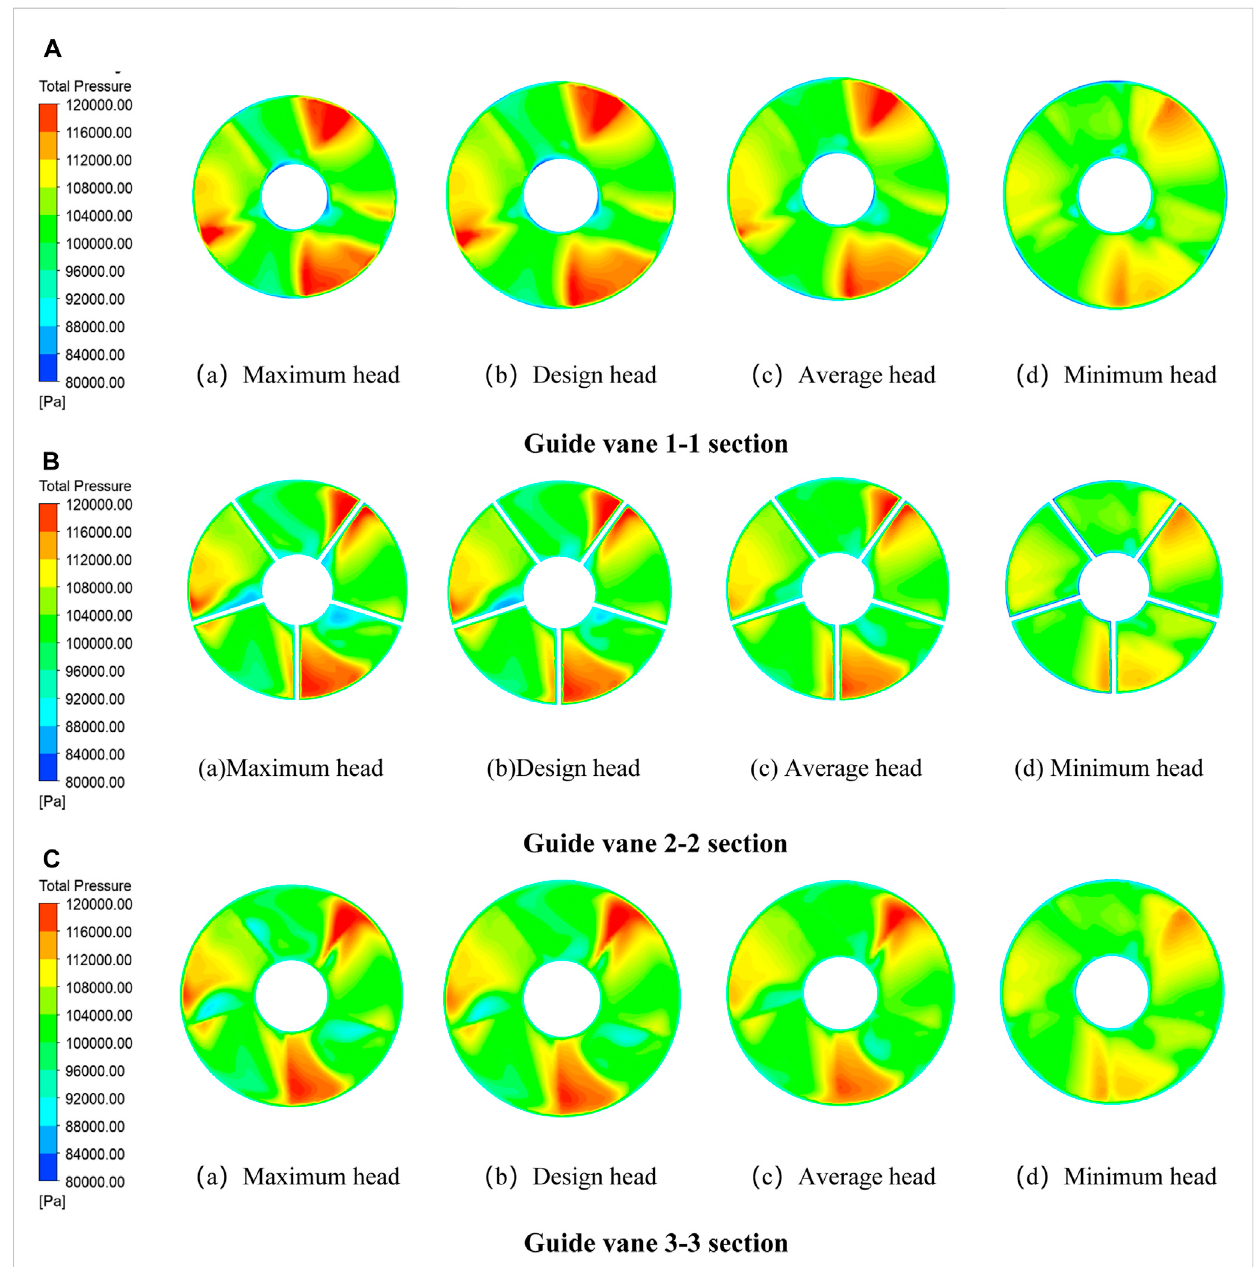
FIGURE 8 Guidevanedomainpressurecontour. (A) Guidevane1-1section.(a)Maximumhead.(b)Designhead.(c)Averagehead.(d)Minimumhead. (B) Guide vane 2-2 section. (a) Maximum head. (b) Design head. (c) Average head. (d) Minimum head. (C) Guide vane 3-3 section. (a) Maximum head. (b) Design head. (c) Average head. (d) Minimum